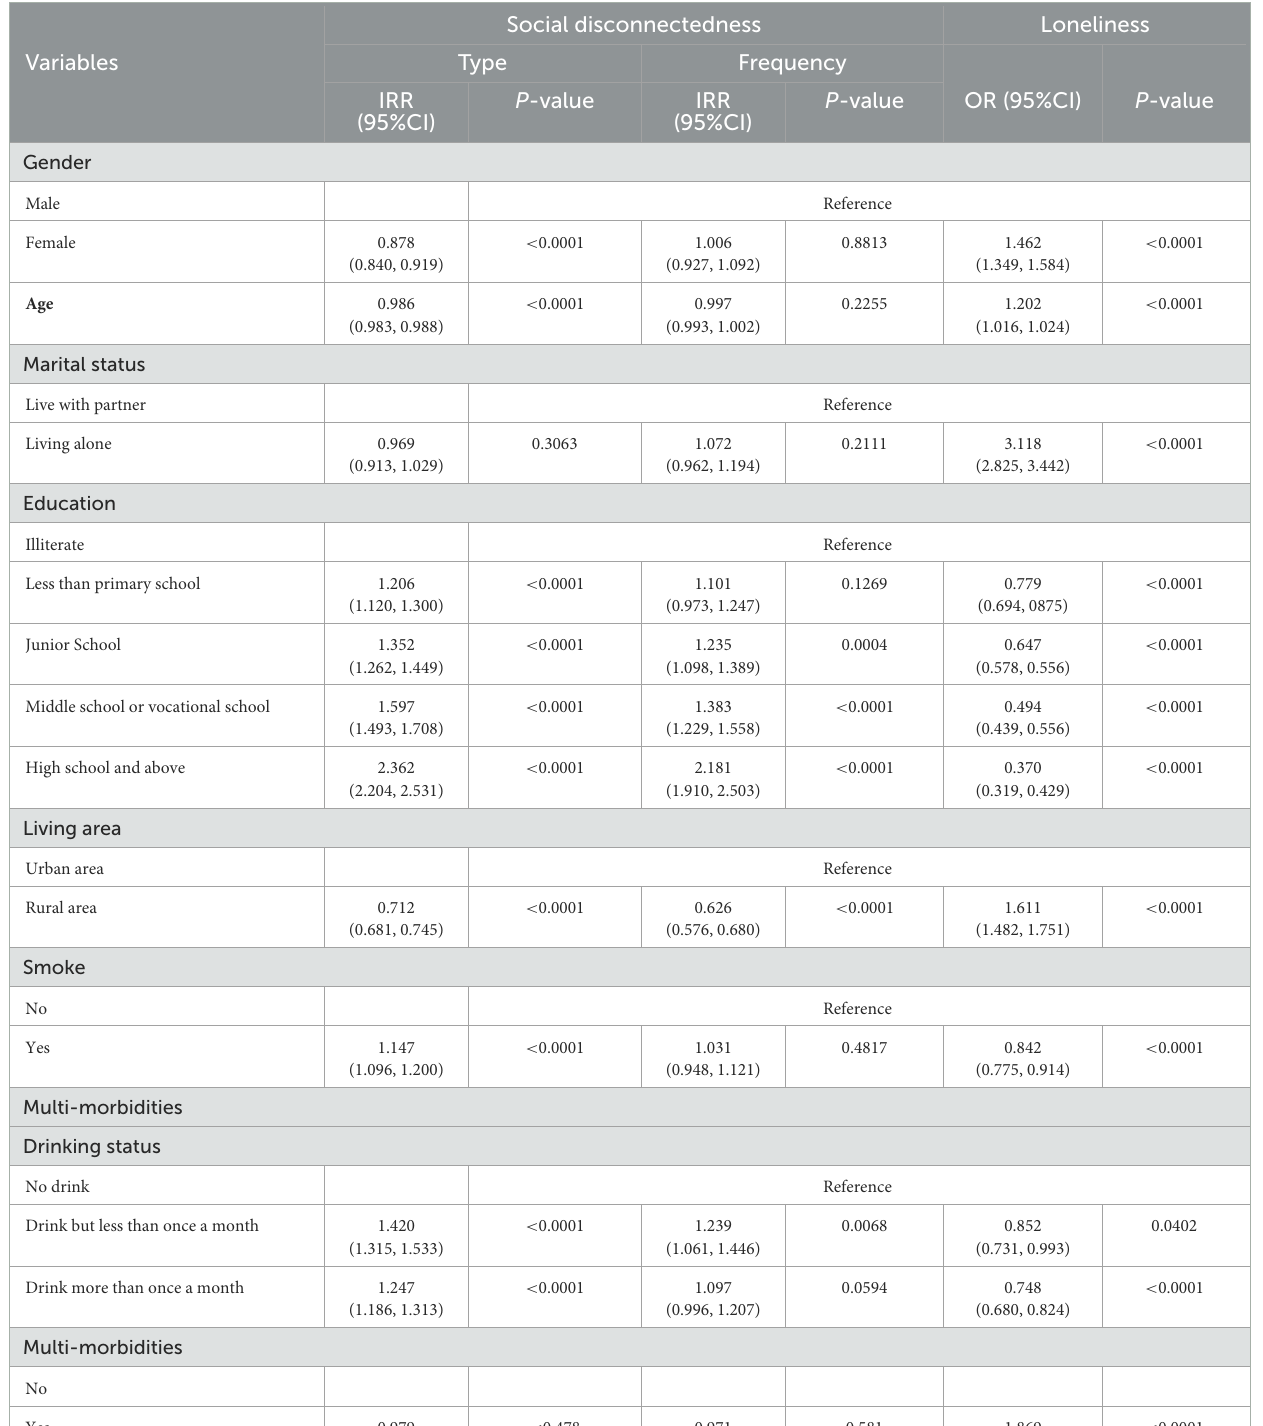
TABLE 2 Univariate generalized linear analysis of independent variables and social isolation measurements in